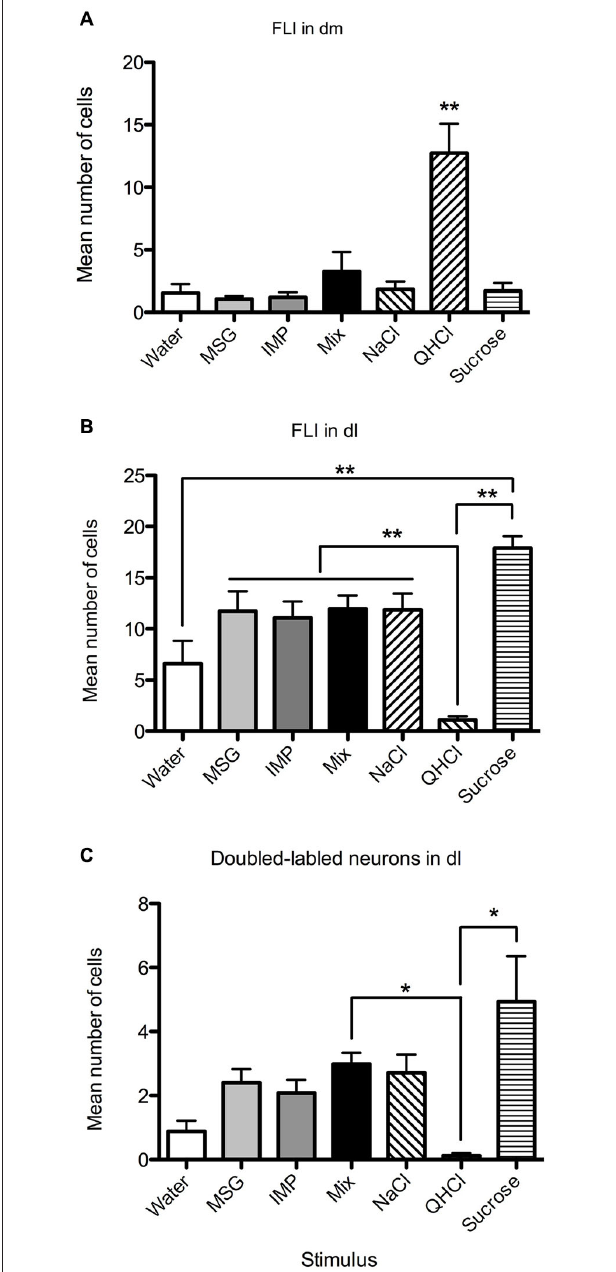
FIGURE 6 | Quantification of labeled neurons in particular PbN subnuclei. These plots highlight group differences shown in Figure 5 (same data). (A) QHCl evoked significantly more FLI in cells in the dm than did other stimuli. (B) Sucrose evoked significantly more FLI in cells in the dl than QHCl or water; all groups significantly differed from quinine. (C) QHCl stimulation resulted in significantly fewer double-labeled cells than were found with sucrose or the mixture. Significance was established with post-hoc testing ( A–B , Bonferroni; C , Dunn’s test); * p < 0.05; ** p <